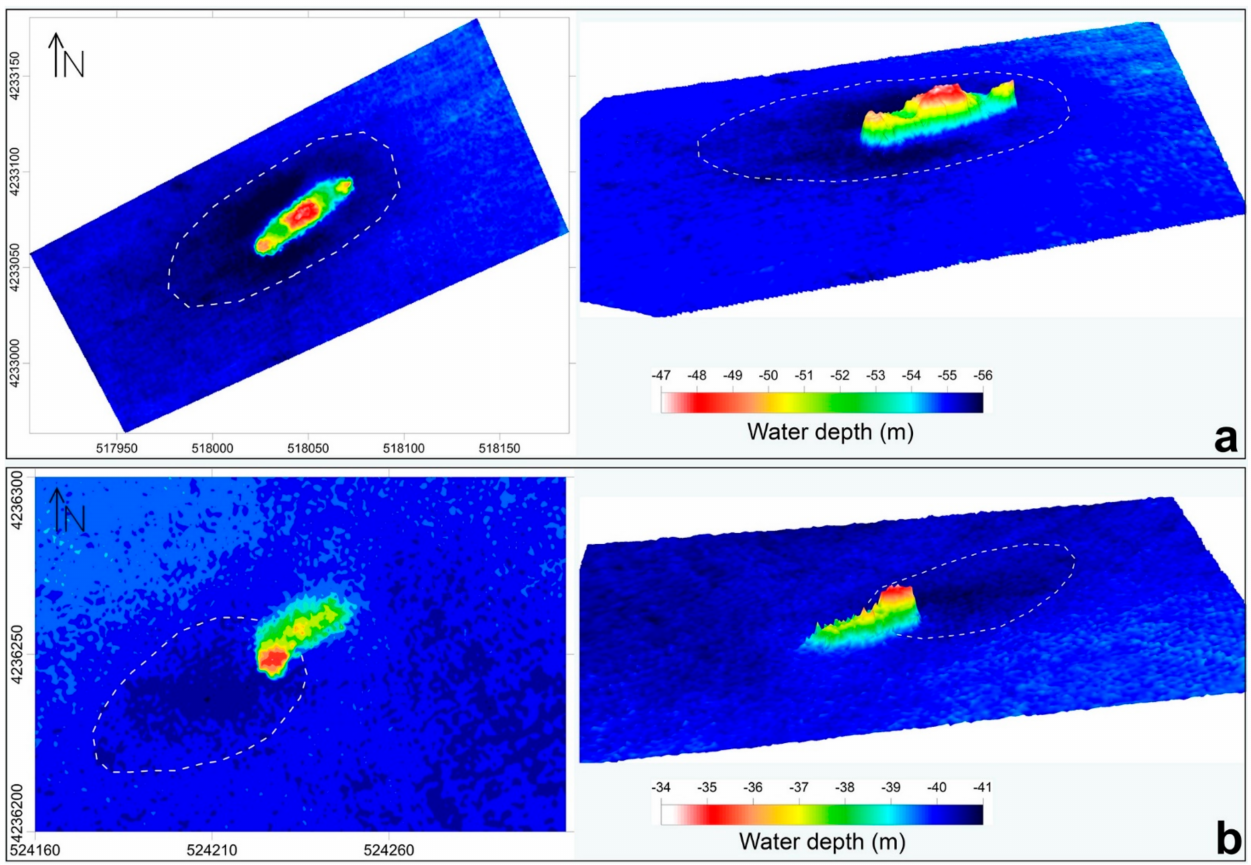
Figure 10. Multibeam 2D and 3D bathymetric maps showing seafloor depressions around ( a ) the “pump house” wreck and ( b ) the bow of the “old iron”